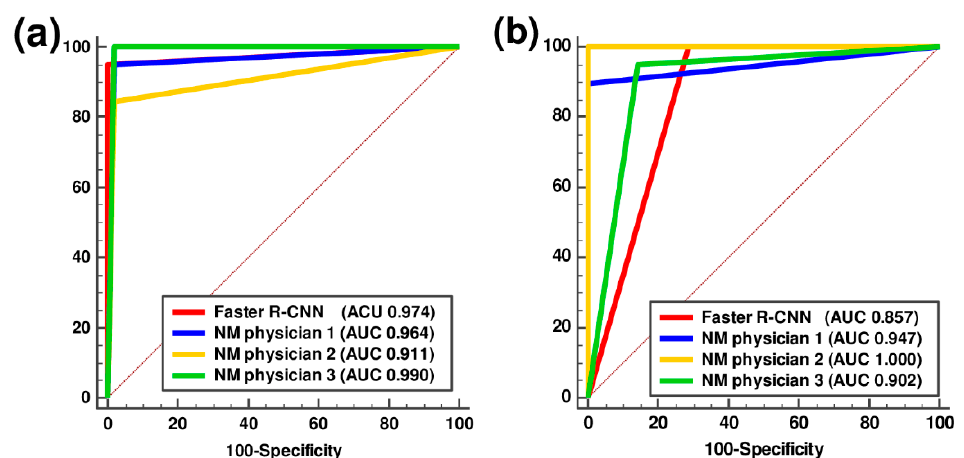
Figure 5. Receiver-operating characteristic curve analysis of the faster region-based convolutional